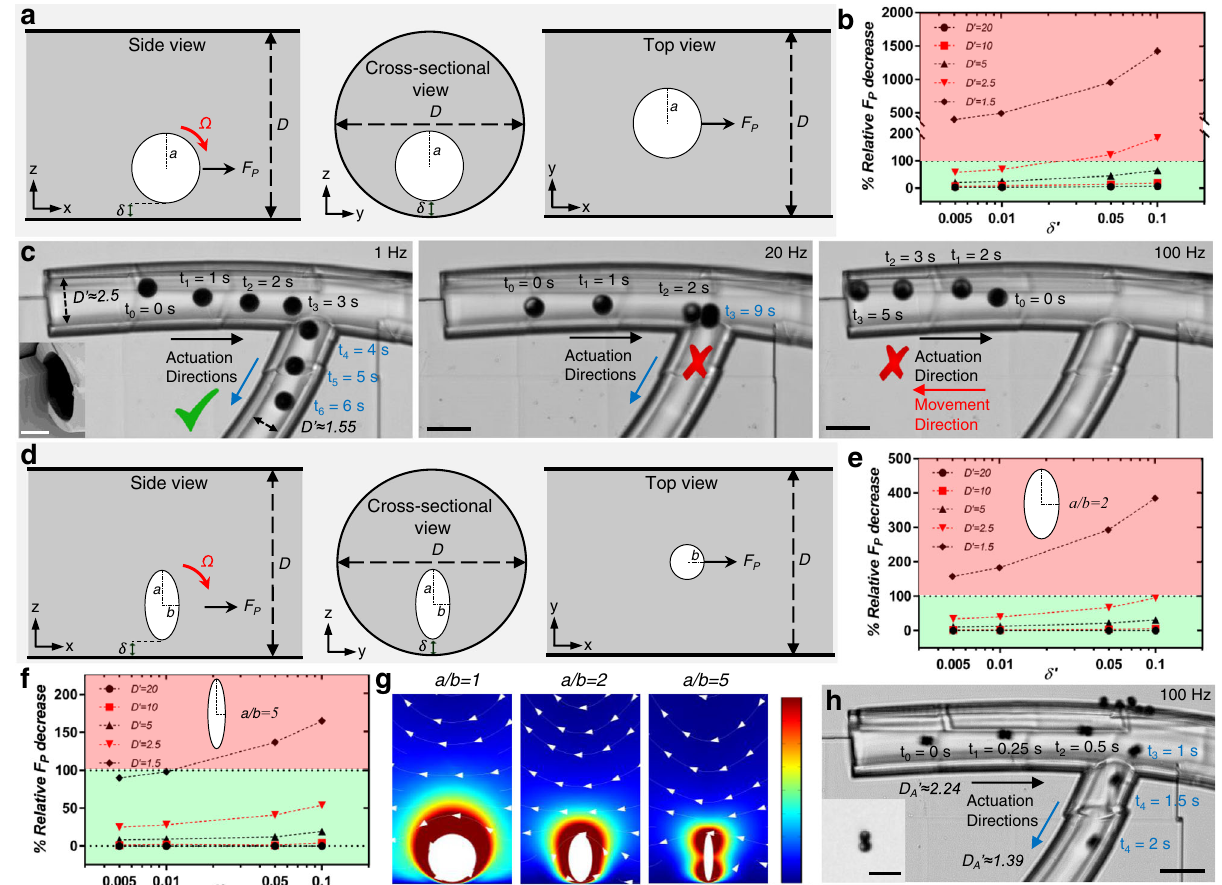
Fig. 5 | Locomotion of spherical and slender microrollers in con fi ned circular microchannels. a A rotating microroller simulated in a cylindrical microchannel, shown from different perspectives. b Universal propulsion force decrease depending on δ ’ at different channel diameters ( D ). The force decrease exceeded 100% (red area), meaning the propulsion force reversed at the con fi ned cases at higher δ ’ . This indicated that the microrollers could reverse their intended trans- lational direction at high frequencies in con fi ned channels. c Locomotion in 3D microprinted circular microchannels. The inset in the fi rst image shows the tilted scanning electronmicroscopyimage of the inletofthecircularcon fi nement (Scale bar: 10 μ m). The microroller was able to locomote at f =1Hz in the microchannels with two different circular con fi nements ( D ’ = D/2a ≈ 2.5 and 1.55 ) . However, when the frequency was increased to f =20Hz, while the microroller could still move in the bigger microchannel, it could not enter the smaller one. When the frequency was further increased to f =100Hz, the locomotion direction of the microrollers was reversed, as predicted in the CFD analyses. The scale bars are 25 μ